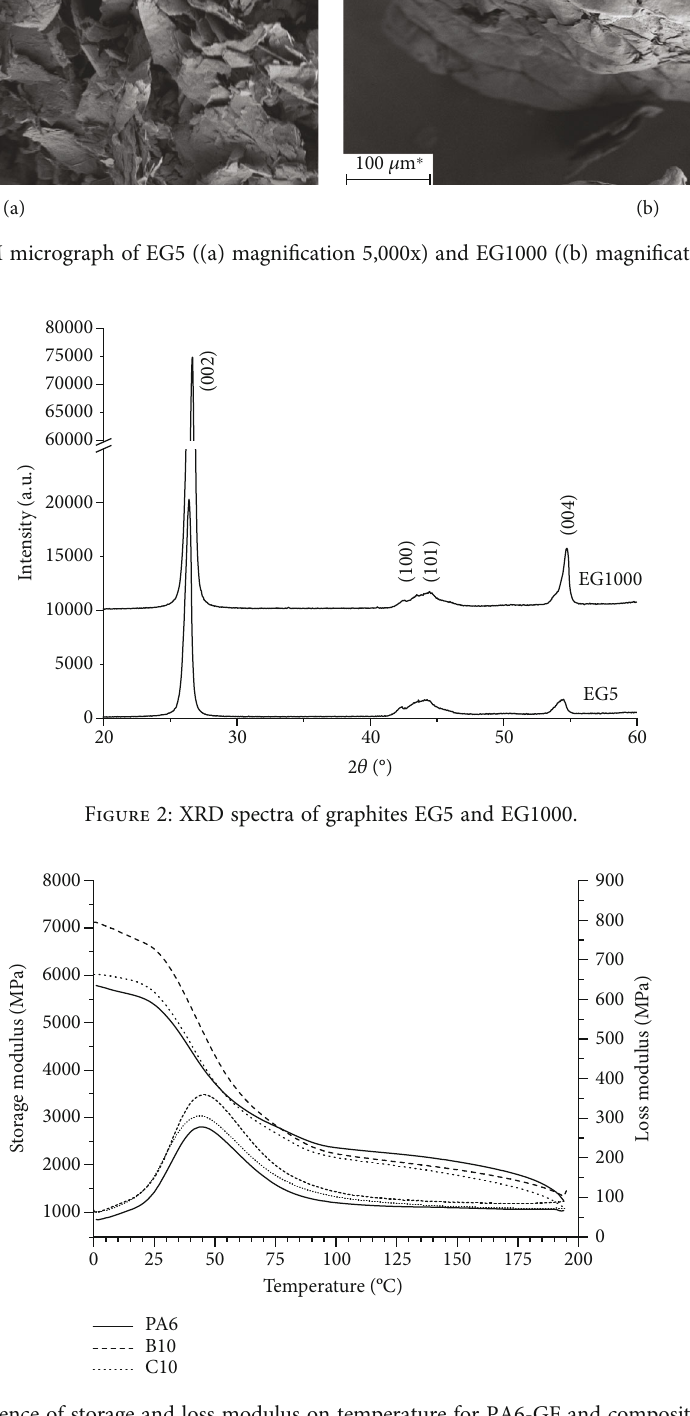
Figure 3: The dependence of storage and loss modulus on temperature for PA6-GF and composites with 10wt%